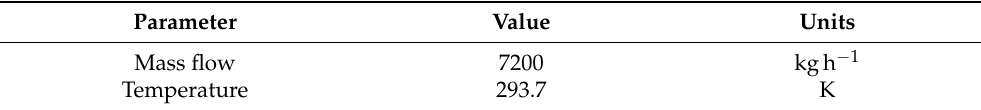
Table A6. Model parameters of the Washing water inlet used in the flowsheet simulations of the zeolite catalyst production process.